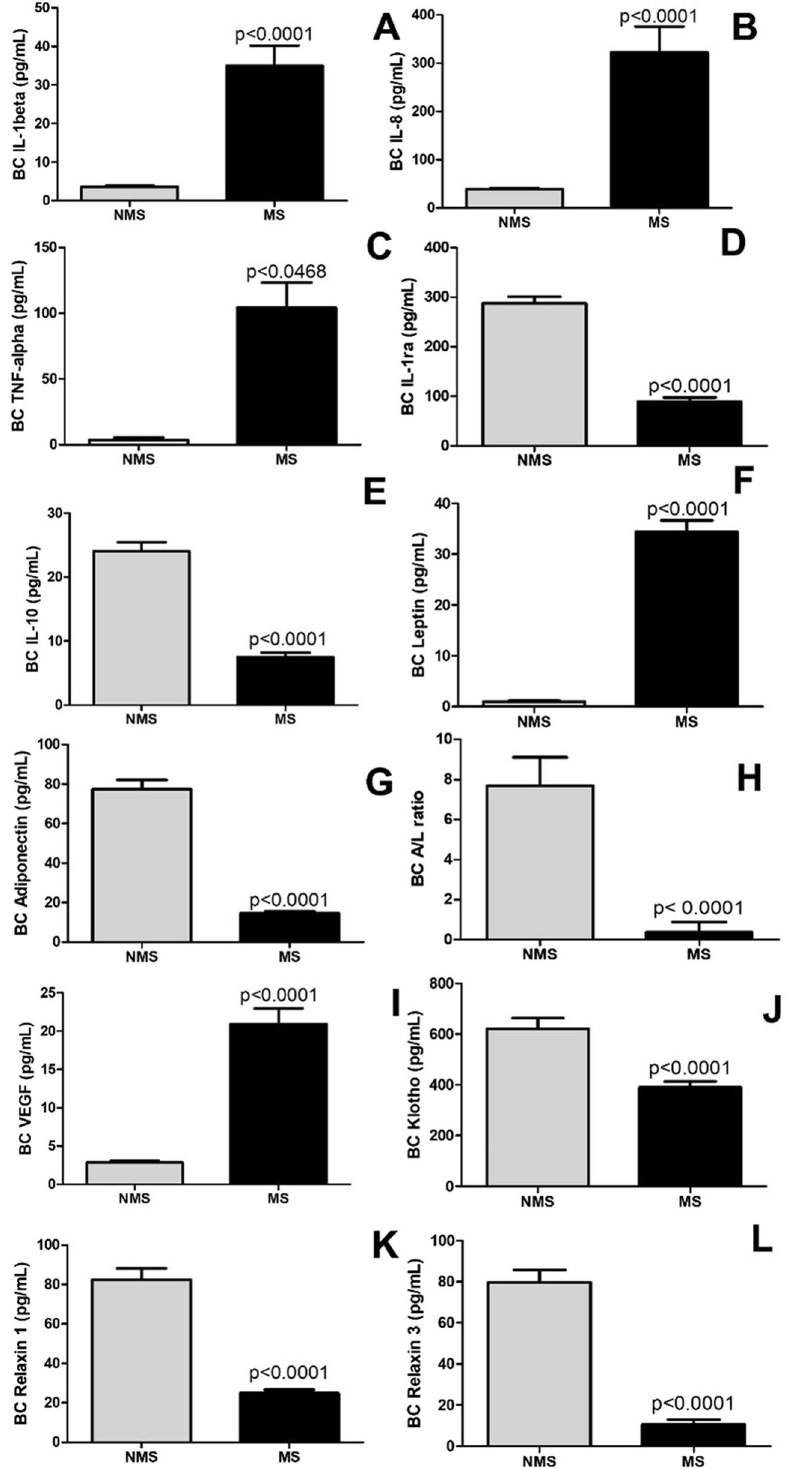
Figure 2. Immunological mediators in breath condensate (BC) in older adults with and without metabolic syndrome (MS). Figure 2A (IL1-beta), Figure 2B (IL-08), Figure 2C (TNF-alfa), Figure 2D (IL1ra), Figure 2E (IL-10), Figure 2F (Leptin), Figure 2H (Adiponectin), Figure 2G (Leptin/Adiponectin ratio), Figure 2I (VEGF), Figure 2 J (Klotho), Figure 2 K (Relaxin 1), Figure 2L (Relaxin